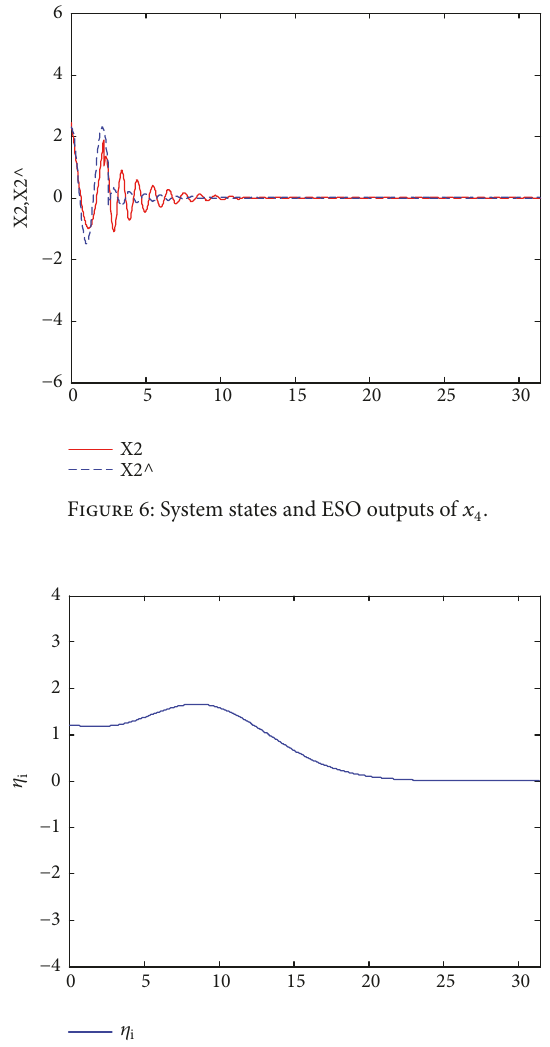
Figure 4: System states and ESO outputs of 𝑥 2 .